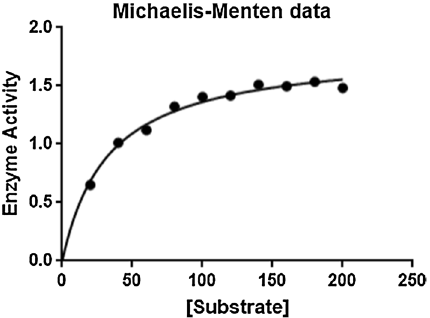
Fig. 7 Michailis–Menten silk peroxidase